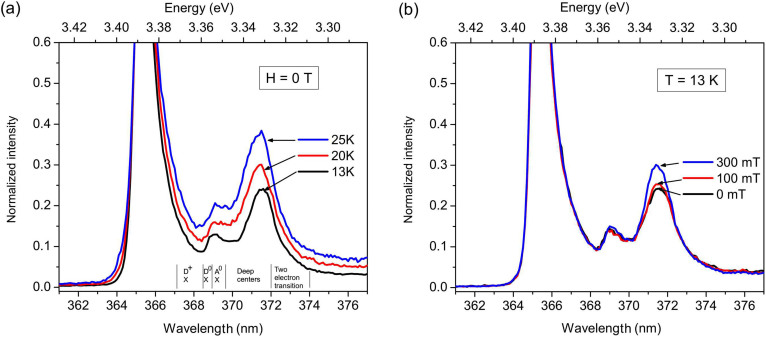
Normalized PL spectra of a Zn0.92Mn0.08O film at (a) increasing temperatures and (b) increasing magnetic field.